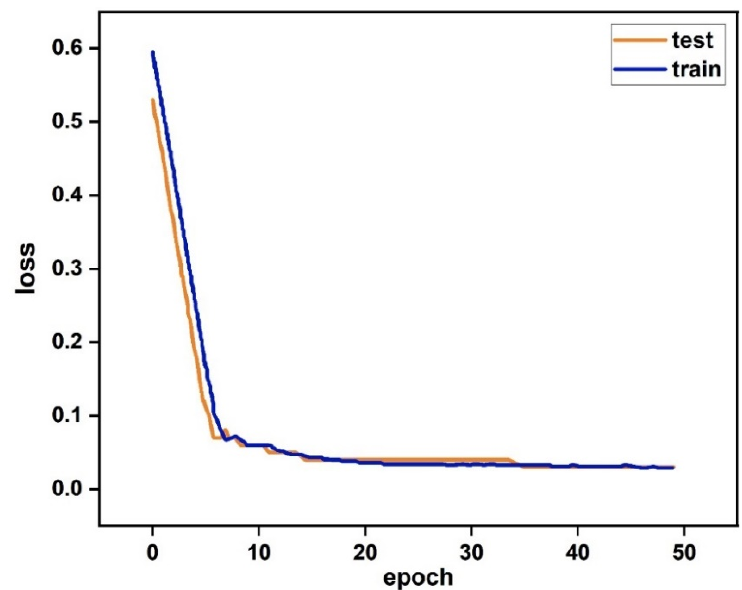
Figure 8. Loss change trend from 1960 to 2010.